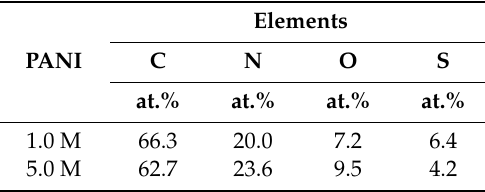
Table 1. Elementary composition of PANIs based on energy-dispersive spectroscopy (EDS) analysis.